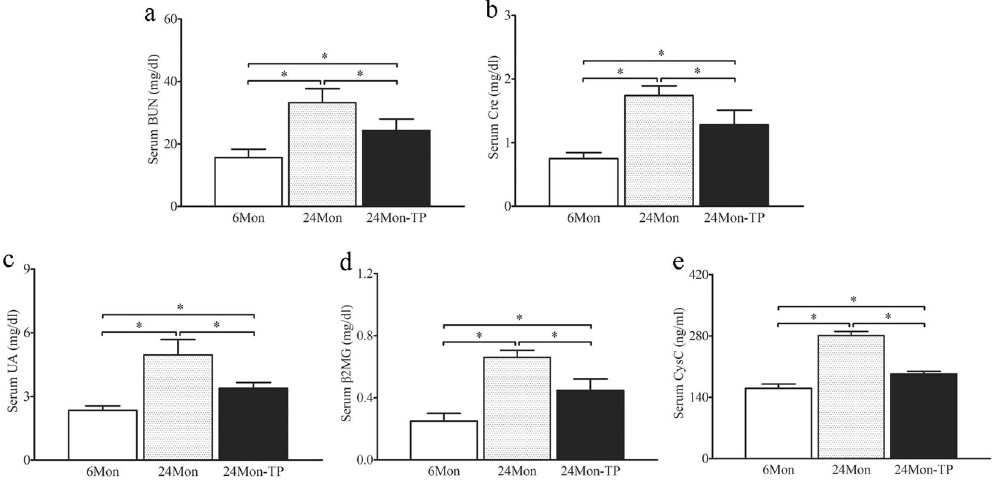
Figure 2. The effects of TP on renal function in aged rats. The serum level of BUN ( a ), Cre ( b ), UA ( c ), β 2MG ( d ) and CysC ( e ) was measured by ELISA. The asterisks show significant differences ( * P <